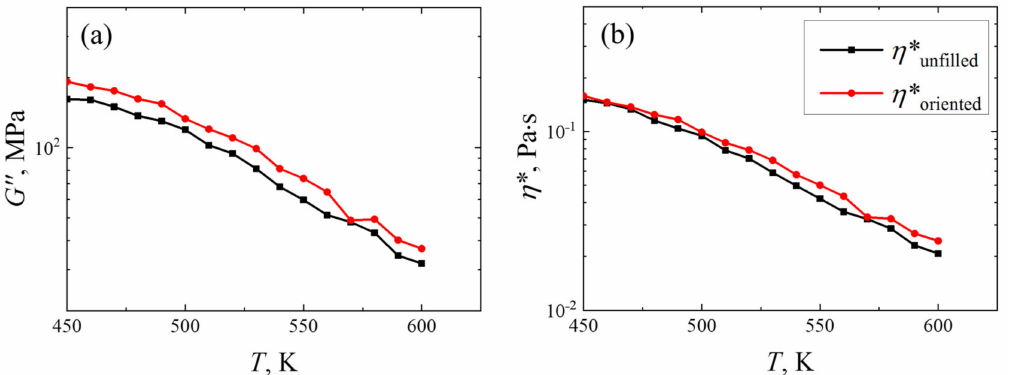
Figure 5. Temperature dependence of ( a ) loss modulus G (cid:48)(cid:48) and ( b ) complex viscosity η ∗ of unfilled amorphous ( η ∗ unfilled ) and R-BAPB samples oriented by SWCNT ( η ∗ oriented ). The rheological properties of amorphous unfilled R-BAPB samples were taken for comparison from a previous study [75]. The error bars are compared to the size of the symbols. The results were obtained by computer simulations using Equations (1) and